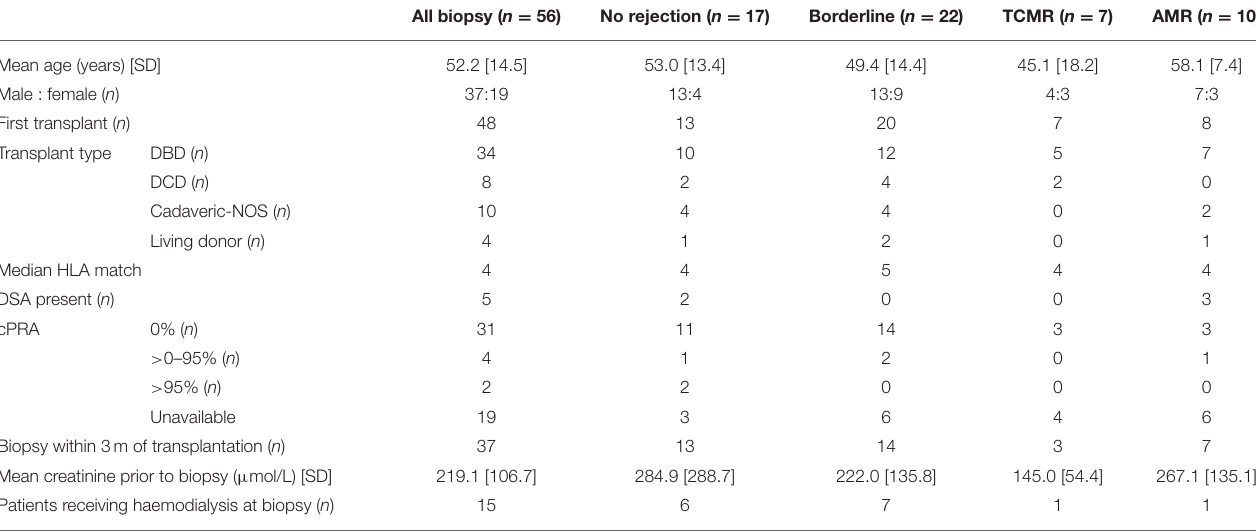
Patients receiving haemodialysis at biopsy ( n )